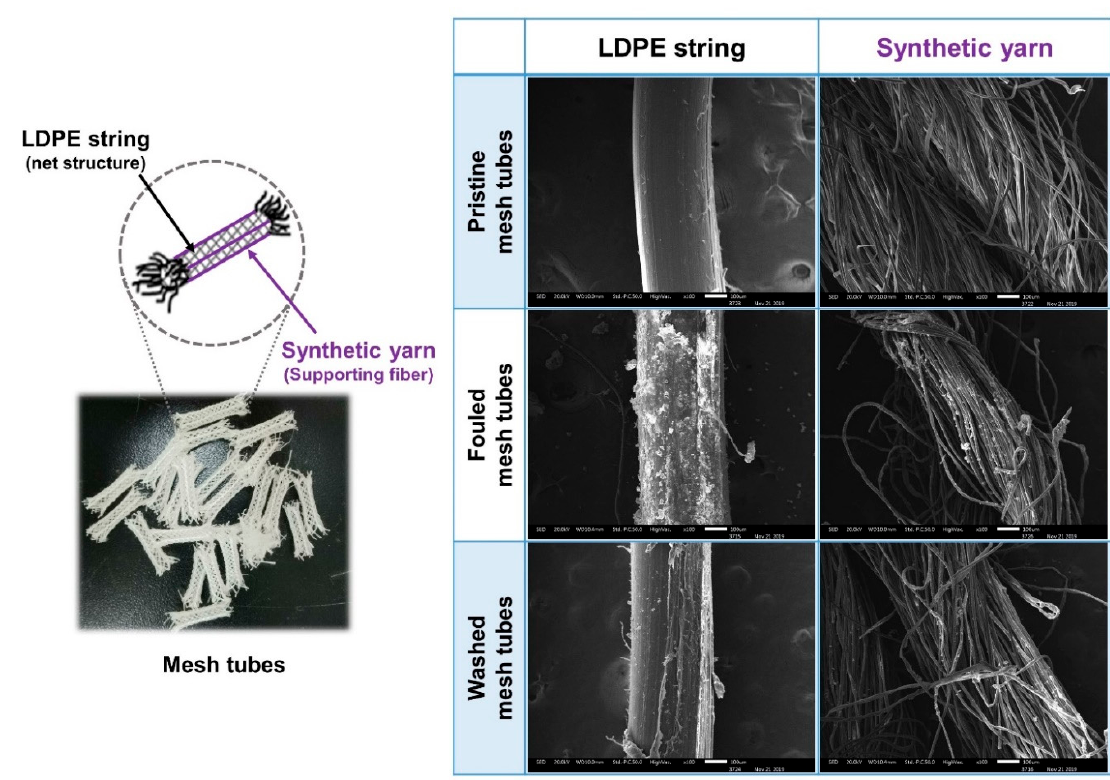
Figure 12. LV-SEM image of contaminated and washed surfaces of LDPE string and synthetic yarn.